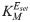
Negative Feedback Loops with and without Integral Control.(a) Flow diagram illustrating the concept of integral control. The regulated value of A is compared with its set-point Aset and the integral E of the error e between A and its set-point is calculated. E is fed into the process to compensate uncontrolled inflow or outflow to and from A. (b) Scheme of an inflow controller, where integral control is represented by removing E with enzyme Eset, which is saturated with substrate E and reflected by a low KMEset value. (c) Illustration of robust homeostasis in A for different k1, k2 combinations with set-point k4/VmaxEset
Eq (6). The change in k1 and k2 occurs at t = 50.0 and t = 100.0 time units indicated by the arrows. Rate constants: k3 = 1.0, k4 = 2.0, VmaxEset=1.0, and KMEset=1×10-4. Initial concentrations: A0 = 2.0, and E0 = 3.0. (d) Same negative feedback loop as in (b), but without integral control. The saturating kinetics of the E-removal is now replaced by a first-order process with respect to E with k5 = 1.0. The system is now not able to maintain robust homeostasis in A. Initial concentrations and the other rate constants are as in (c).